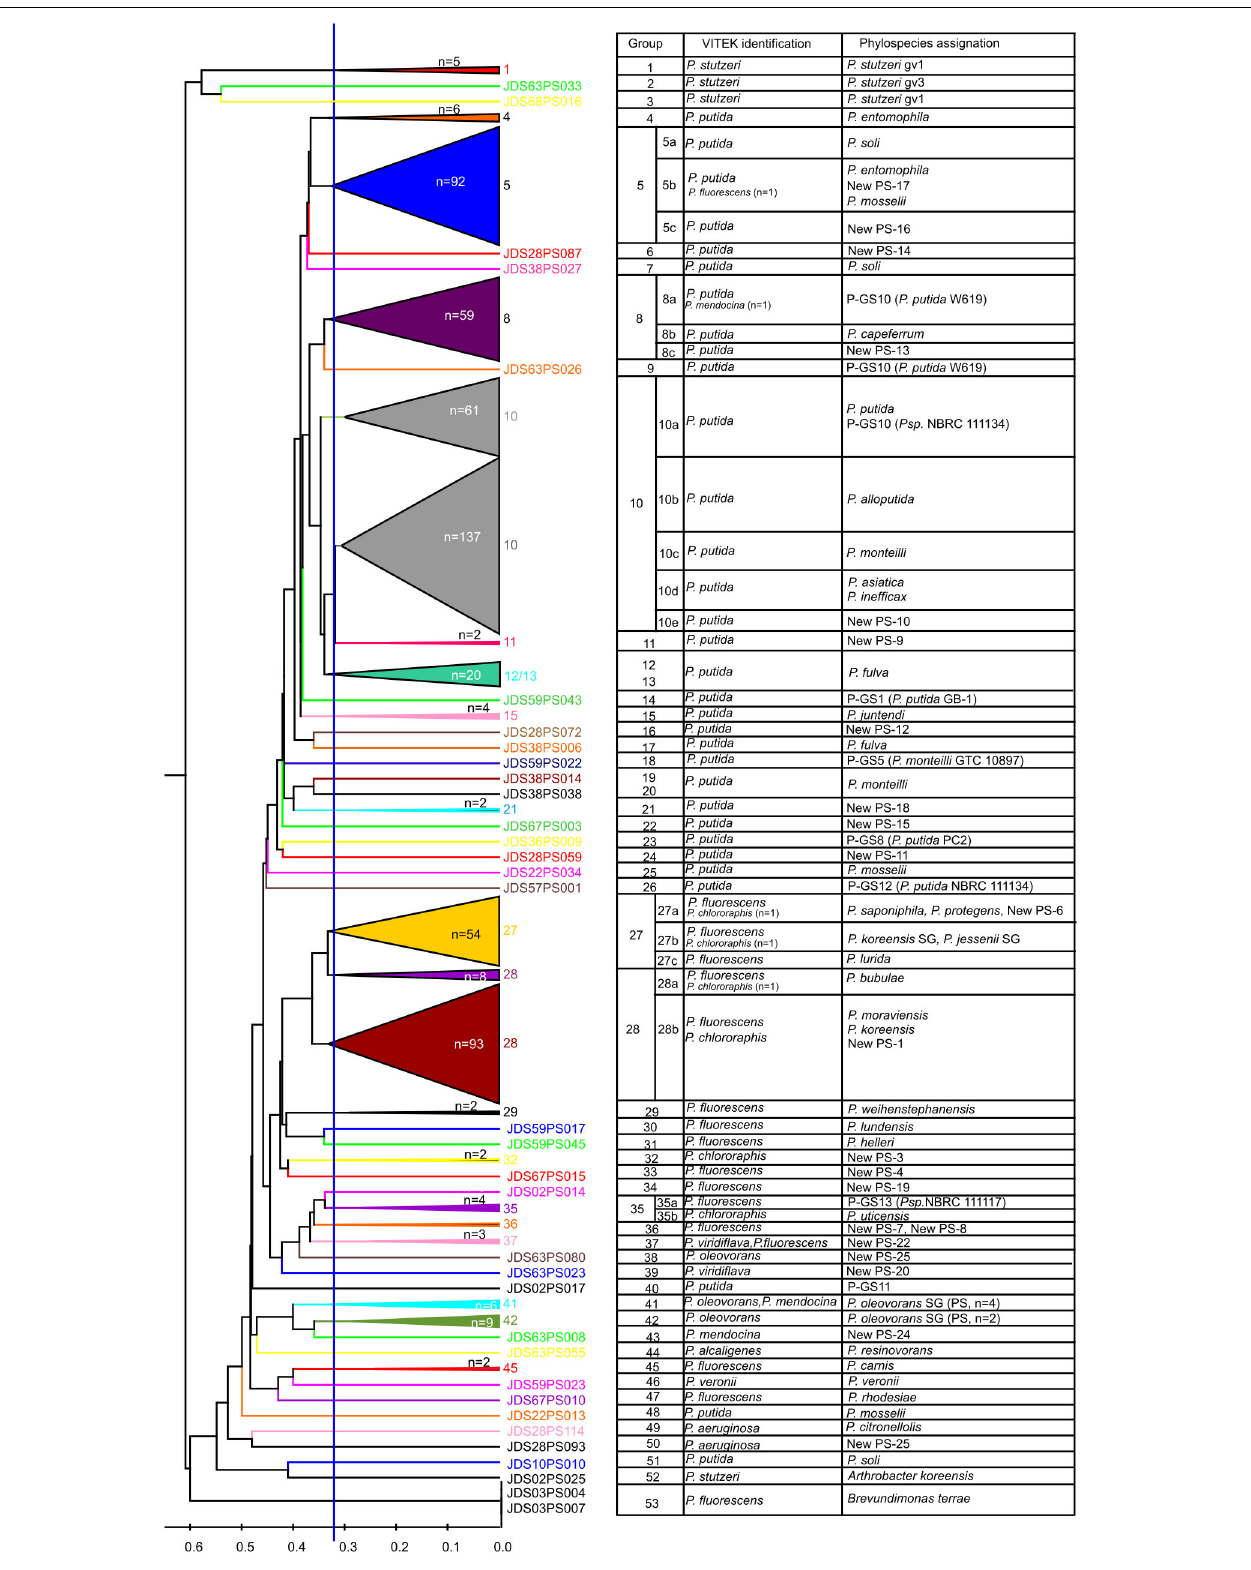
FIGURE 1 | UPGMA dendrogram of the 611 isolates based on the similarities of the MALDI-TOF MS protein profiles, their VITEK identification and assignation to phylospecies by rpoD sequencing. On the basis of the rpoD sequences, several groups are subdivided and labeled with letters (a, b, and c, etc.).